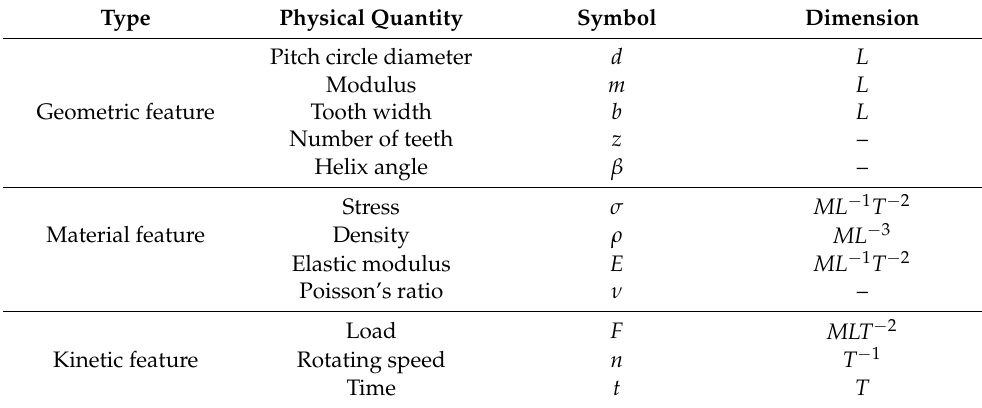
Table 1. Table of physical dimensions in the system.